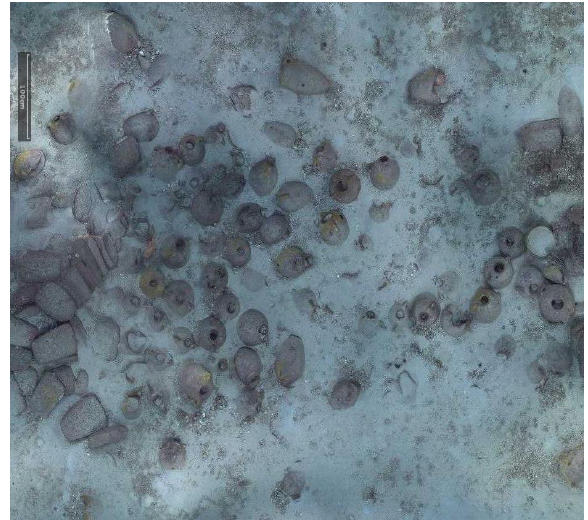
Figure 1. A snapshot taken from a very high resolution orthophoto, the full resolution image can be found in the project’s website (http://www.groplan.eu). The overall image resolution is 41,507 × 60,377 pixels at a scale of 0.005 mm per pixel.